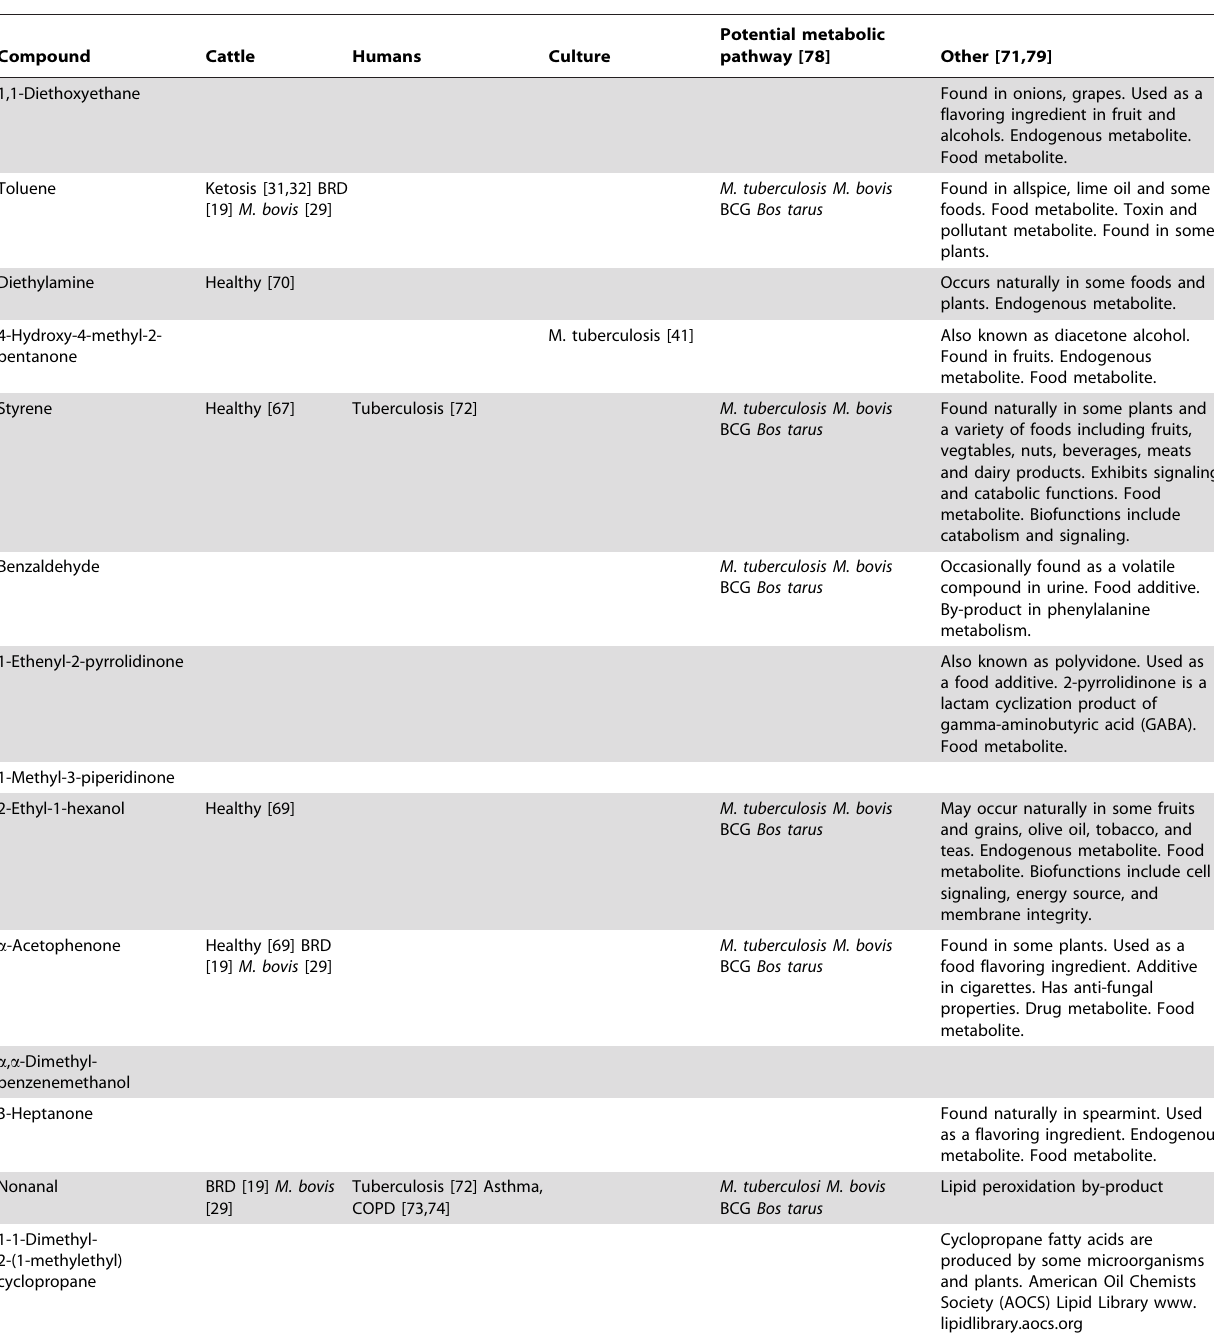
Table 4. Comparison of compounds identified in cattle and